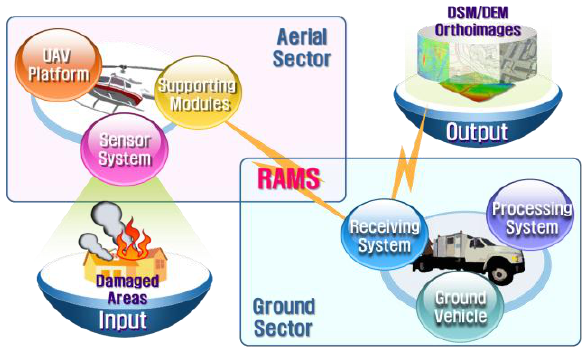
Figure 1. Overview of UAV based close-range rapid aerial monitoring system